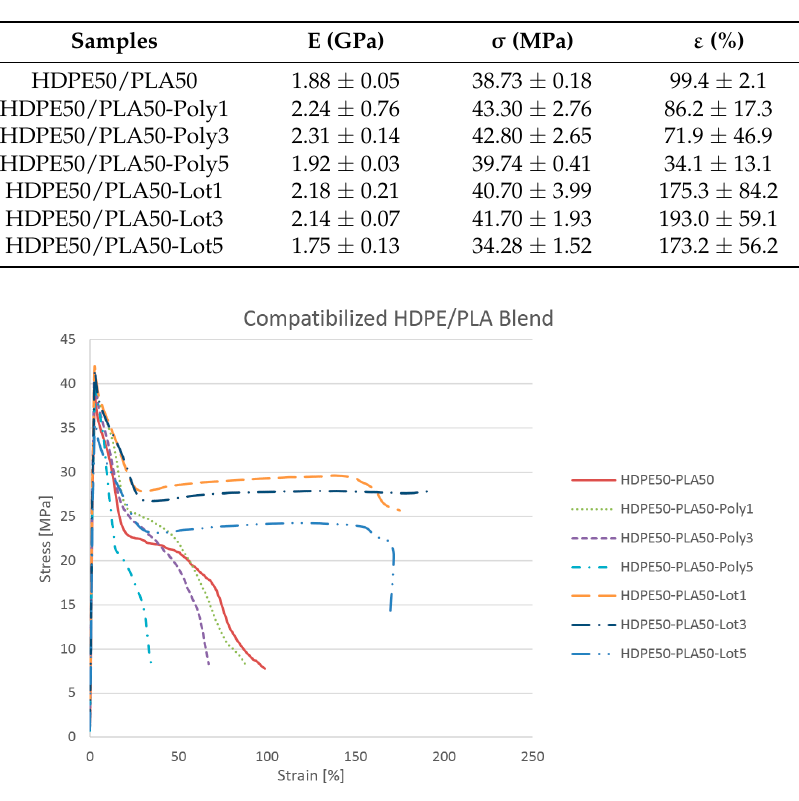
Figure 2. Effect of Lotader AX8840 and Polybond 3029 at 1, 3, and 5 wt.% on the PE50/PLA50 blend.